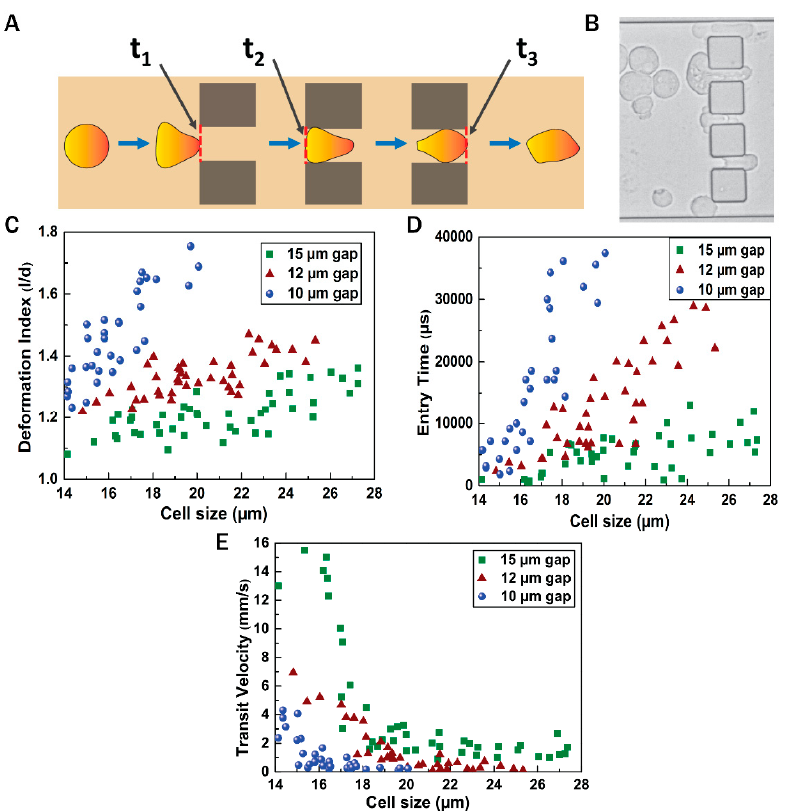
Figure 4. Flow dynamics of cells through blockages. ( A ) Stepwise motion of the cell through a blockage; ( B ) microscopic view of invasion of cells through the gaps between blockages ( C – E ) deformation index, entry time, and transit velocity of the cells through the gaps of varying sizes between blockages, respectively.